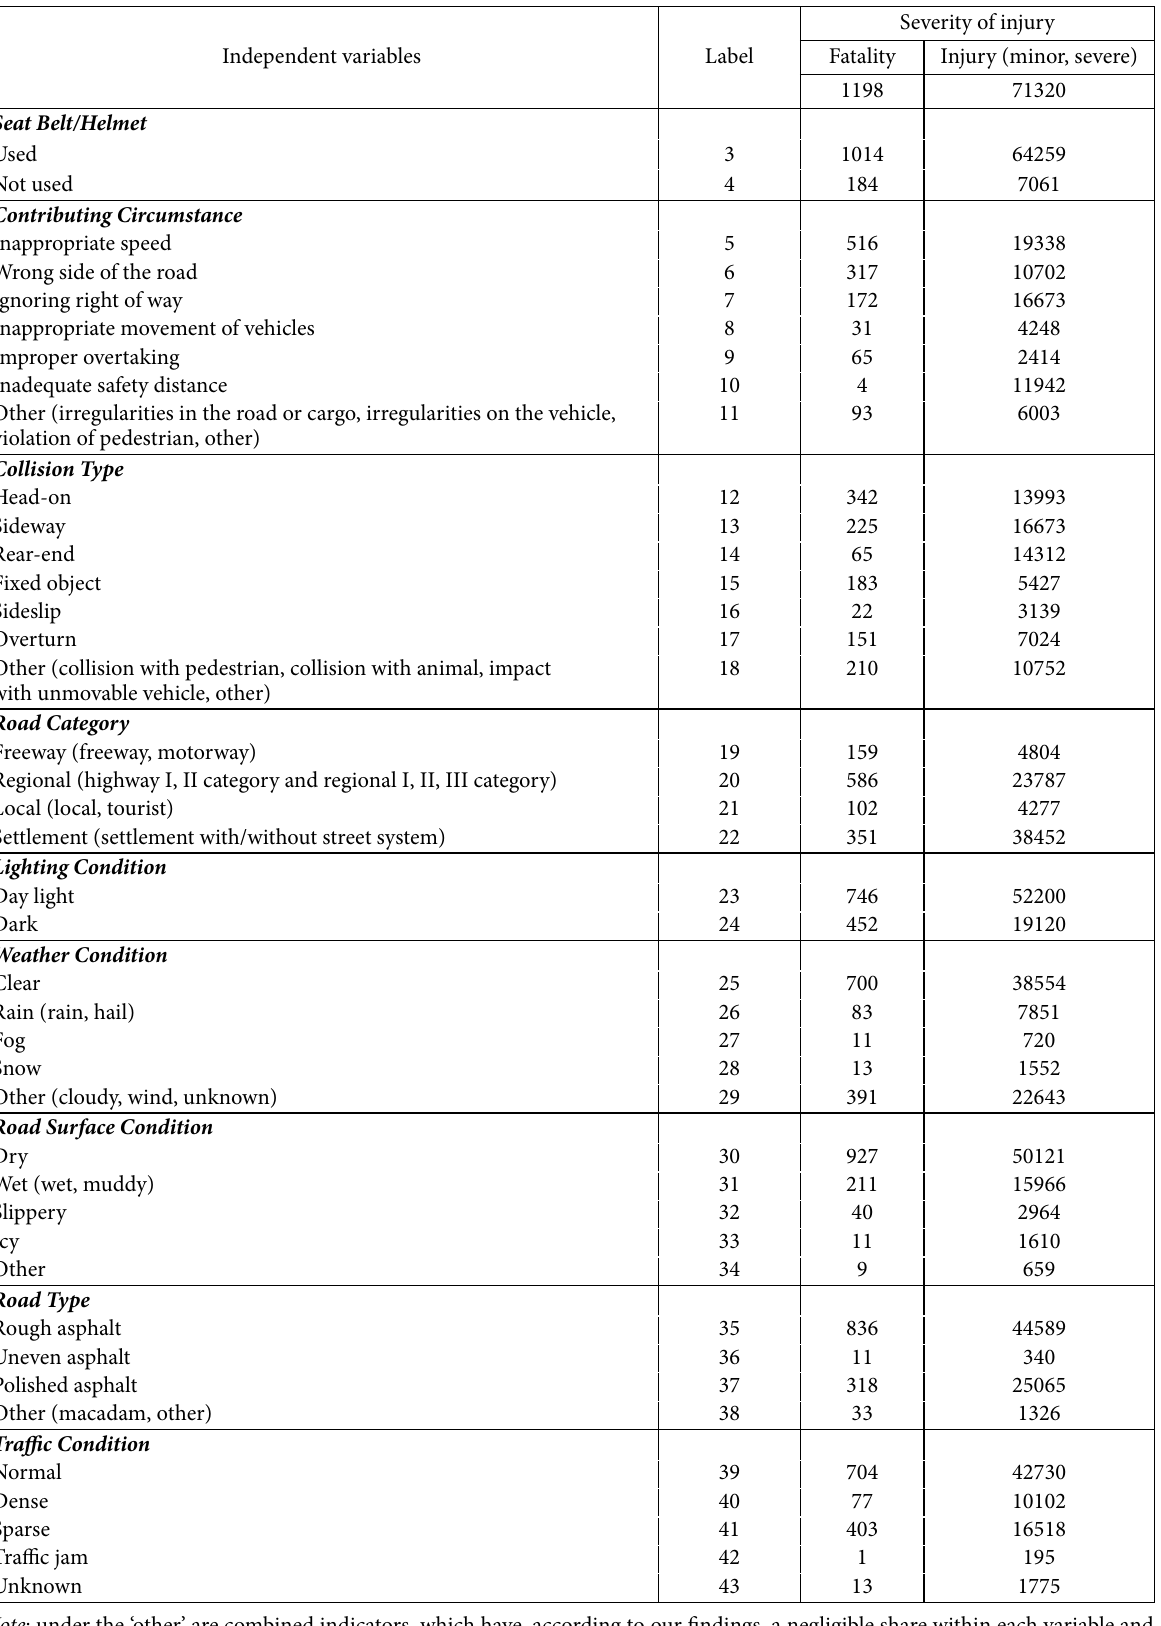
Table 1. Description of the variables included in the